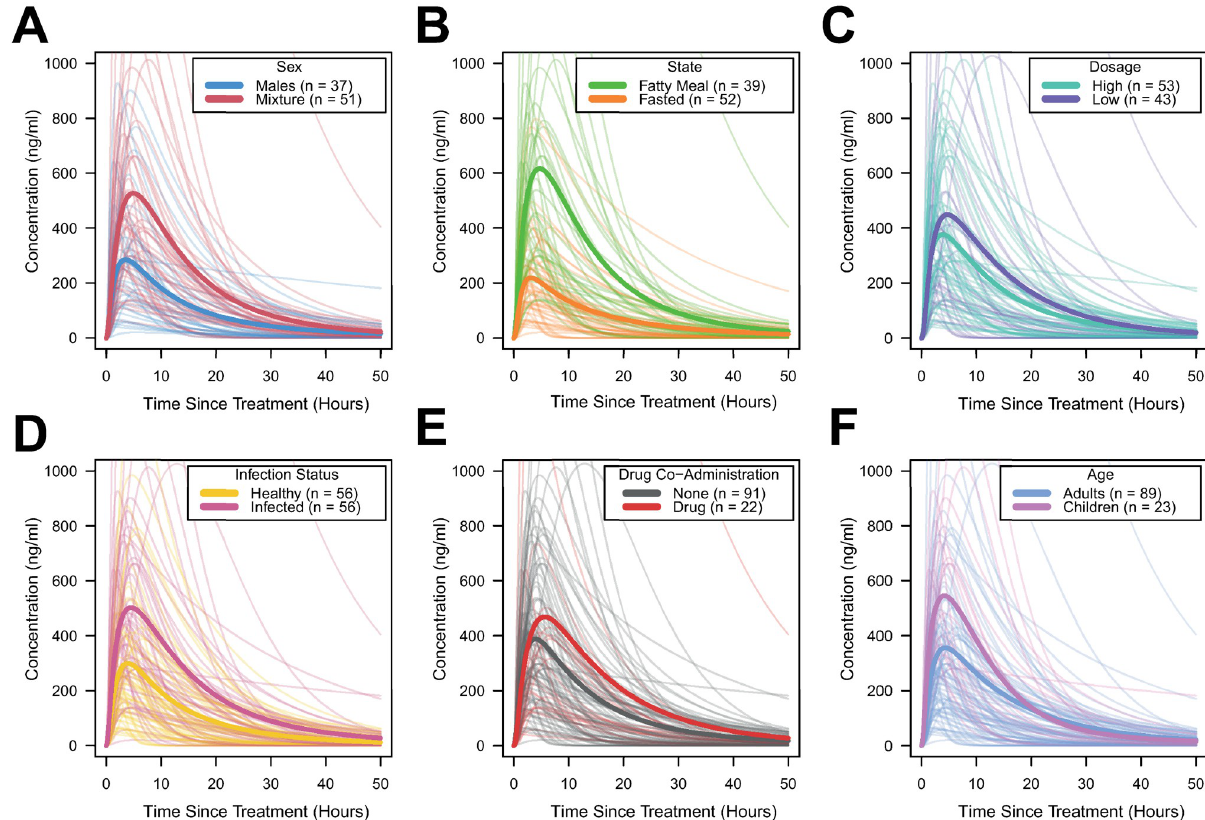
Fig 3. Albendazole sulfoxide pharmacokinetic variability, stratified by patient and dosage features. In all panels displayed above, each pale line represents the fitted model output for a single time-series, with the darker lines representing the average of the time-series for a given category. Factors explored were (A) Sex; (B) Feeding Status (according to whether groups had received the single dose of albendazole alongside a fatty meal or not); (C) Dose (with time-series crudely categorised into high/low strata based on whether the dose was higher or lower than 400 mg); (D) Infection Status (defined, following the article associated with each time-series, as whether the patient group were receiving treatment for a known infection or not); (E) Co-Administered Drugs (i.e. whether albendazole was delivered alone or in tandem with other drugs); and (F) Age Group, defined as to whether the average age of the patients was under 18 years (children) or � 18 years